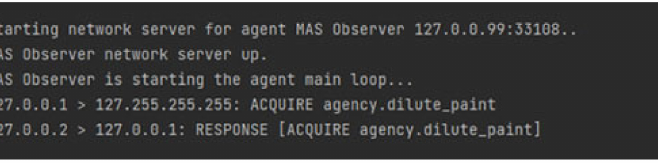
Figure 11. Output of the Multi-Agent System (MAS) Network Observer showing the Intelligence Transfer Model Protocol (ITMP) communication taking place from the advice executing on the pointcut indicated by the red line in Figure